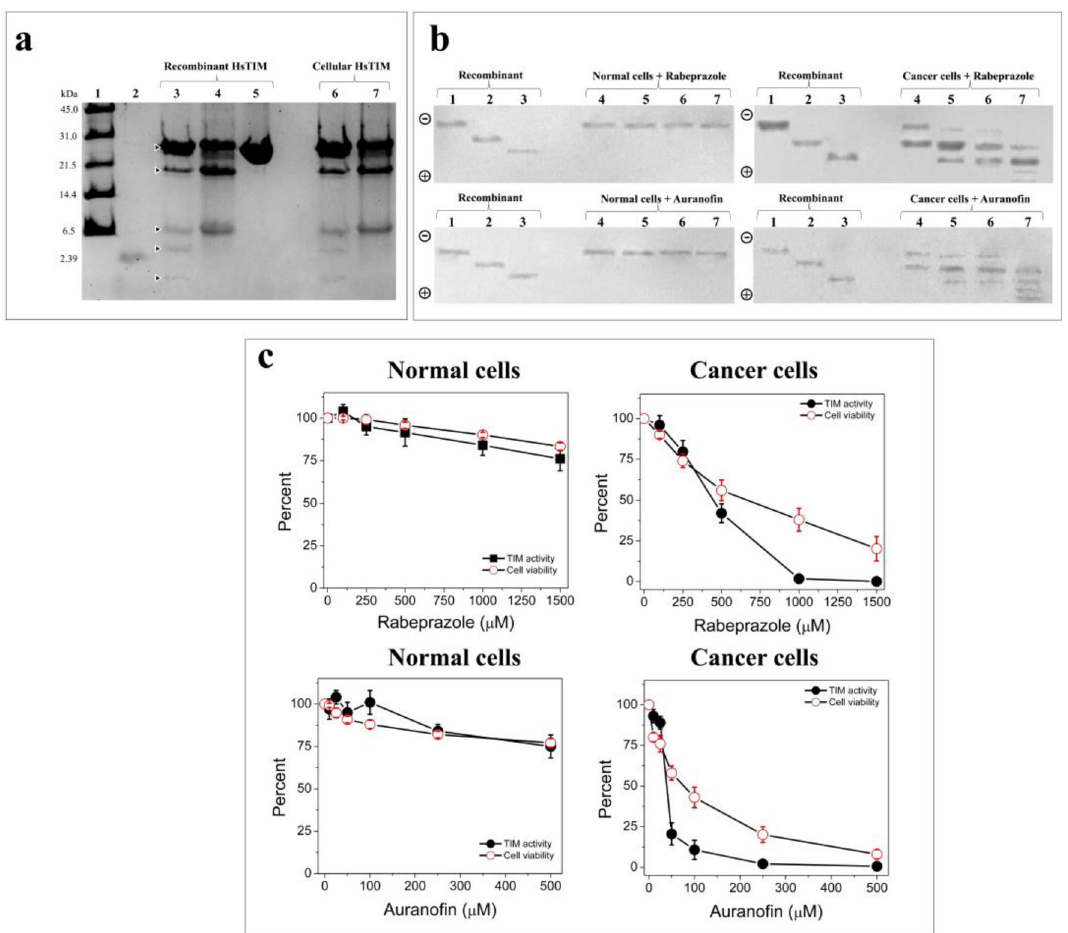
Figure 2. Accumulation of deamidated HsTIM in breast cancer cells and the effects exerted by treatment with thiol drugs. ( a ) SDS-PAGE of hydroxylamine cleavage of the recombinant and cellular HsTIMs: Lane 1: molecular weight standard, lane 2: peptide with a size of 2.39 kDa, lanes 3 to 5: (10 µg of protein/ lane) nondeamidated, once deamidated, and twice deamidated HsTIMs. Lanes 6 and 7: (20 µg of protein/ lane) immunoprecipitated HsTIM from normal and cancer cells, respectively. ( b ) Western blot analysis of recombinant and cellular HsTIMs in nPAGE: Lanes 1 to 3 (1 µg of protein/lane), recombinant HsTIMs nondeamidated, once deamidated and twice deamidated, respectively. Lanes 4 to 7 (100 µg protein/lane), total proteins from normal cells (left gels) and cancer cells (right gels) treated with rabeprazole (upper) or auranofin (bottom). Lanes 4: controls, lanes 5 to 7 increasing concentrations of rabeprazole or auranofin, respectively. The polarity of the gels is indicated on the left side of each figure. ( c ) Cellular HsTIM enzyme activity and viability of normal and cancer cells treated with the drugs. Results are expressed as percentages with the values obtained in the absence of the drugs set as 100%. The results are the mean of four independent experiments. Full-length gel and blots of ( a ) and ( b ) panels are shown in Suppl. Fig.